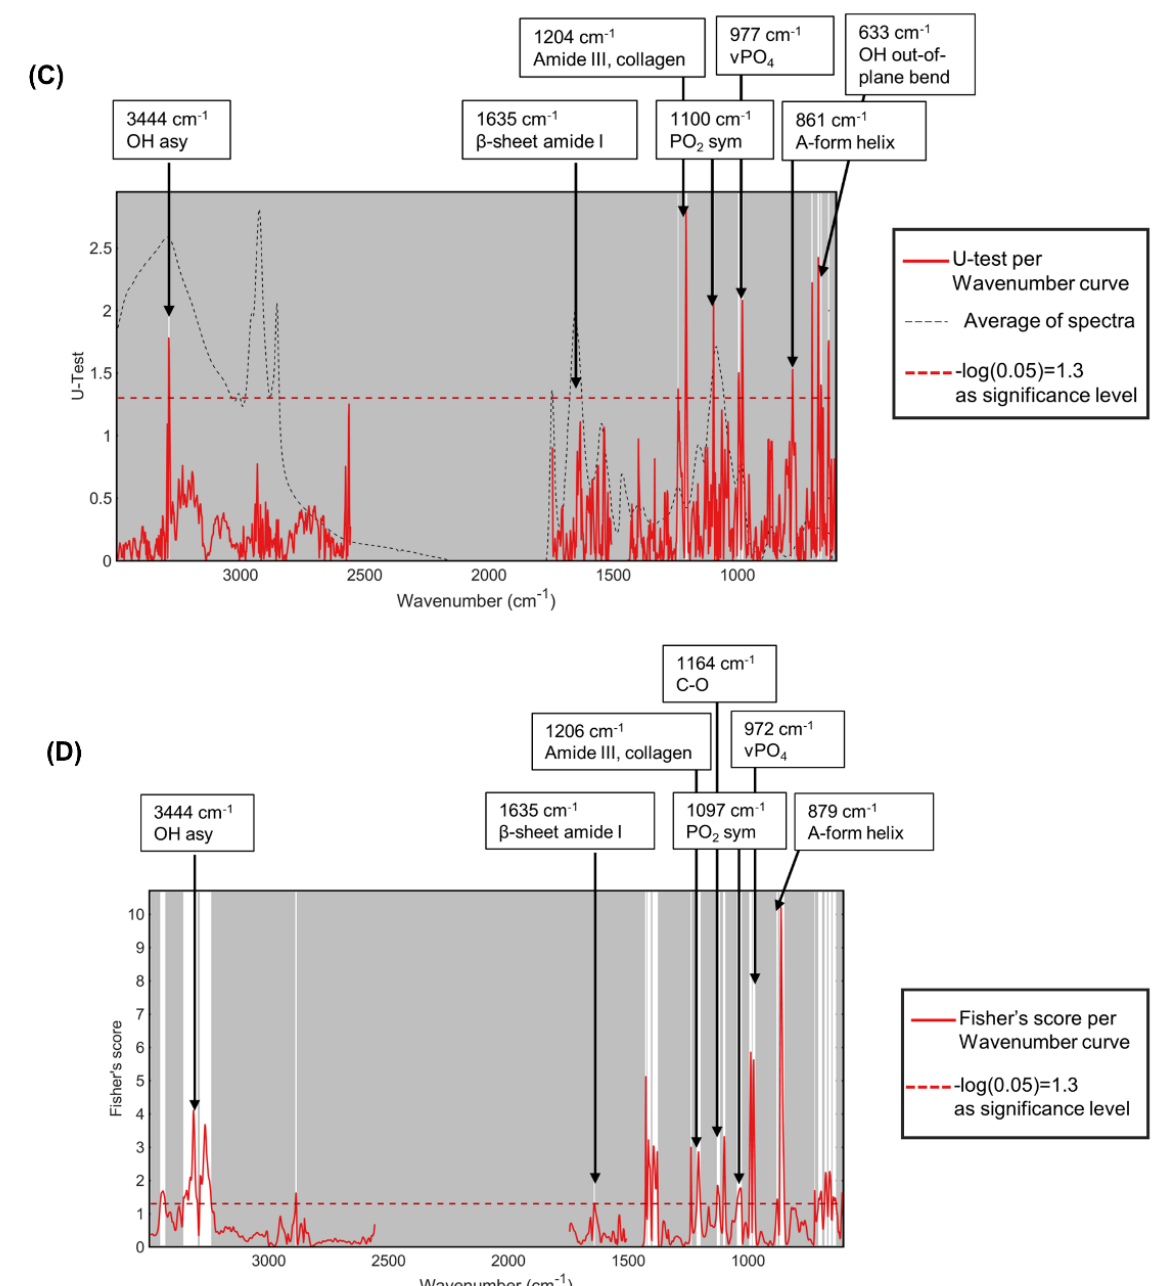
Figure 3. Infrared spectral biomarkers of hBA. ( A ) The differences between mean spectra of hBA and hWA. ( B ) PCA-LDA cluster vector for hBA. ( C ) U-test per wavenumber for hBA. ( D ) Fisher’s score per wavenumber for hBA. − log(0.05) = 1.3, significance level. Table 4. Infrared spectral biomarkers for browning in human adipocytes in adipocyte/conditioned medium.